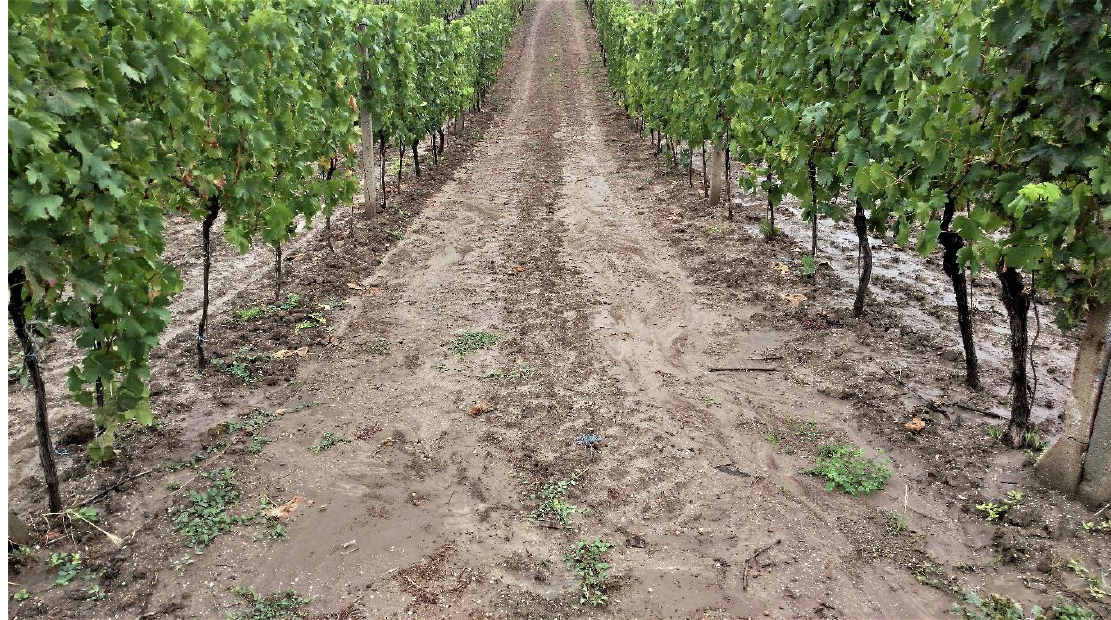
Figure 5. Bare soil in inter-rows leads to serious problems with runoff, soil erosion and damage of soil structure (photography: L. Ragasová, Velké Bílovice, 2018) .